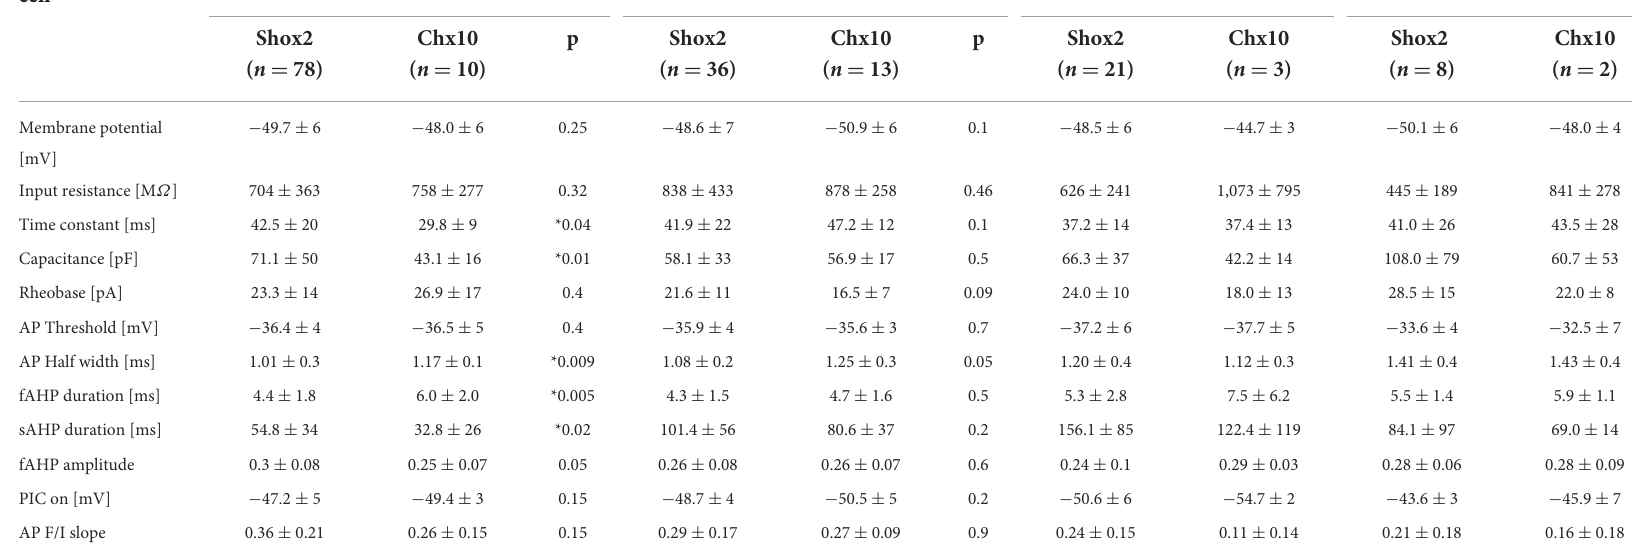
TABLE 1 Comparison of Shox2 and Chx10 neurons within each firing